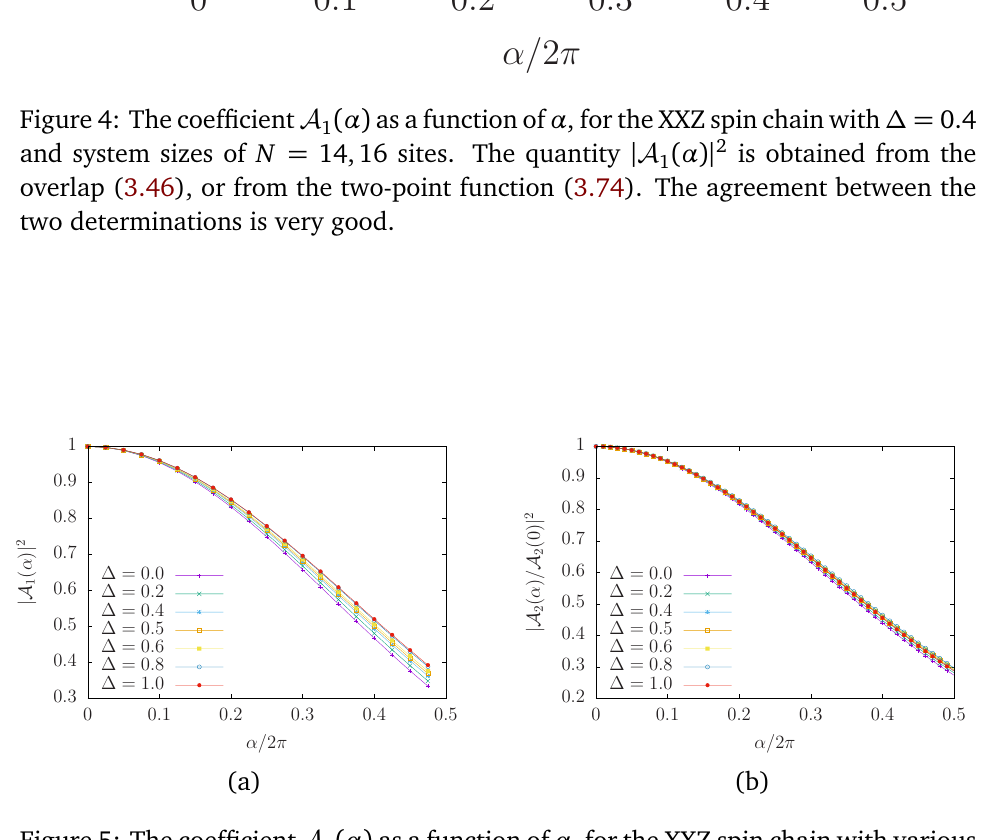
( α ) as a function of α , for the XXZ spin chain with various Figure 5: The coefficient A 1 ( α ) | 2 is obtained from the overlap (3.46), for a values of ∆ . (a) The quantity | A 1 ( α ) | 2 is obtained from the two- system of size N = 16 sites. (b) The quantity | A 2 ( α ) and the fit (3.74), for a system of size N = 16 sites. A small point function (cid:98) Z 2 dependence on ∆ can be observed, which cannot be attributed to finite-size